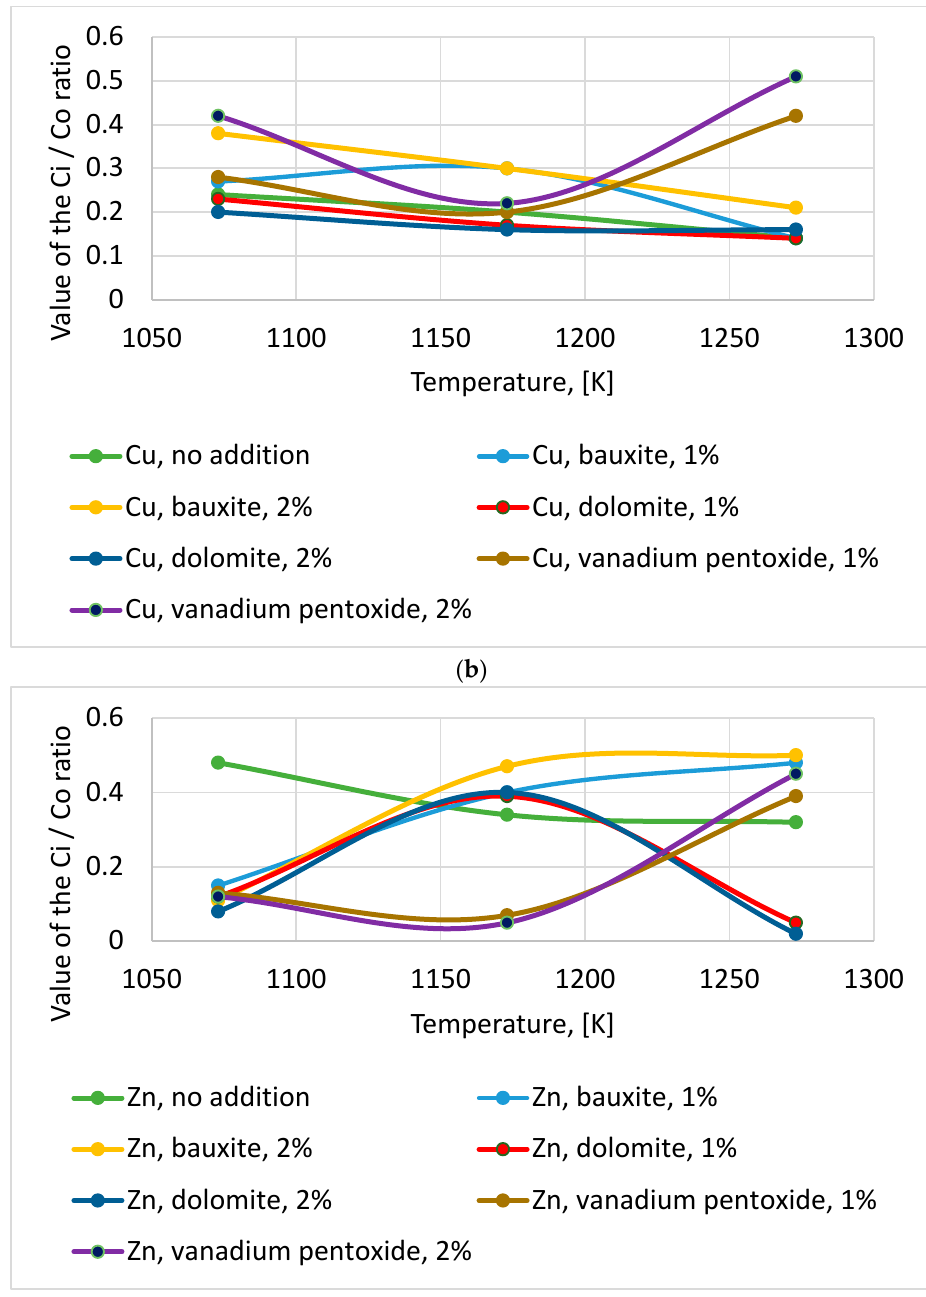
Figure 7. Dependence of the Ci/Co value on the combustion temperature of rubber waste: ( a ) cadmium, ( b ) copper, ( c )